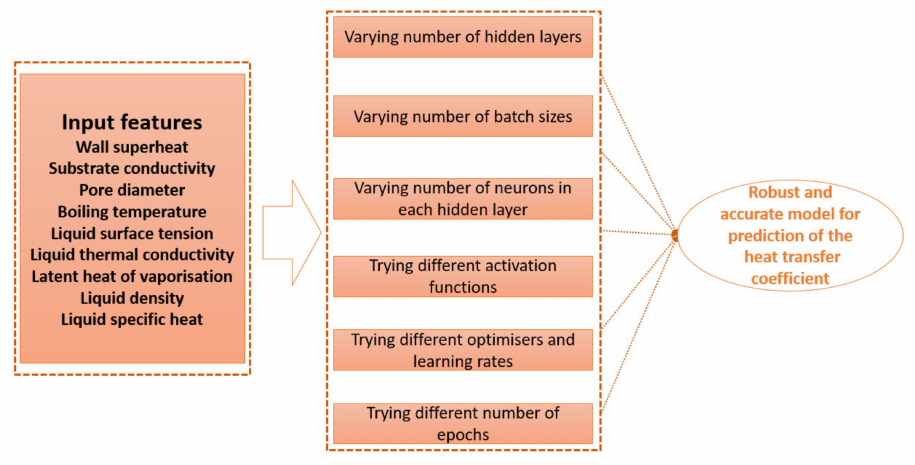
Figure 4. Procedure for finding the optimal model for estimation of HTC for nanoporous surfaces.